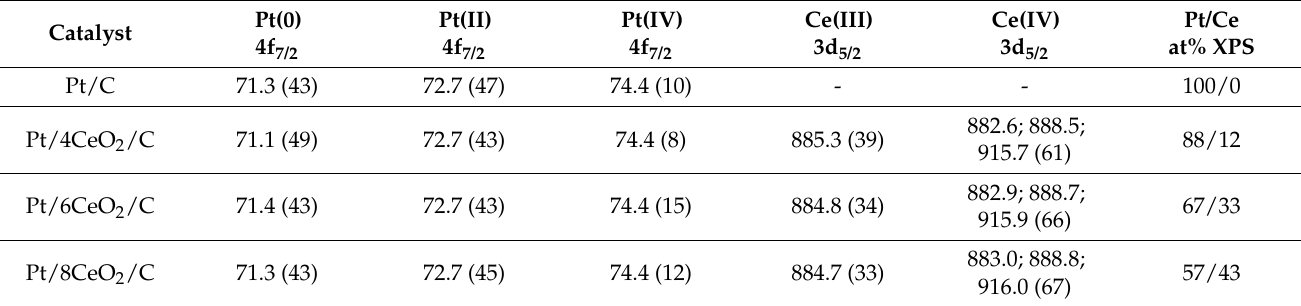
Table 3. Binding energy values of Pt/CeO 2 /C and Pt/C catalysts, with the relative % of different oxidation states indicated in parenthesis and the XPS atomic compositions.